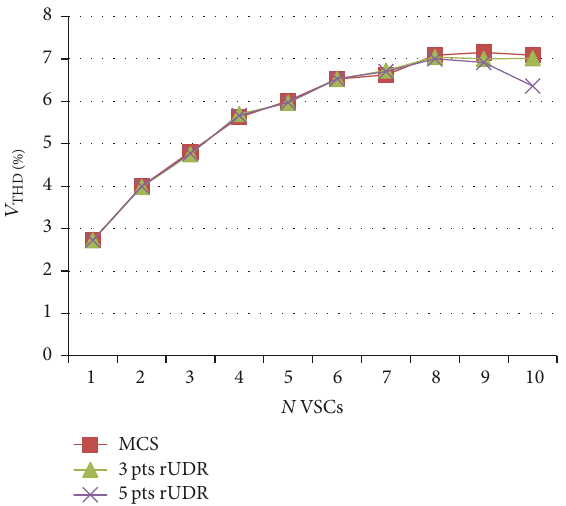
Figure 4: Computation time saved by rUDR 3 pts and rUDR 5 pts.